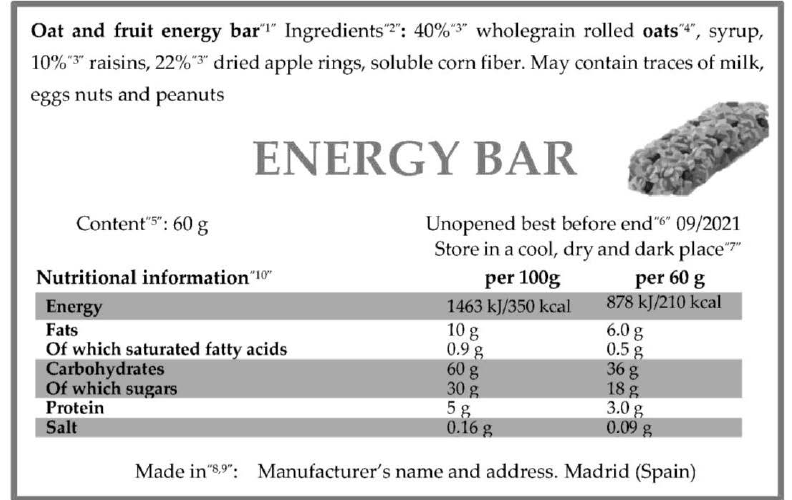
Figure 1. An example of a sport food label. Adapted from a commercial product. According to the European Regulation (Table 1), this sport food includes the following specific information. 1 The foodstuff designation (oat and fruit energy bar) that describes the product. 2 An ingredients list in descending order of weight, preceded by the word ingredients. 3 Quantity indication of certain ingredients or category of ingredients (oats, raisins, apple). The amounts of these ingredients must be indicated because they are mentioned in the name of the food (oat and fruit energy bar). 4 Substances causing allergies or intolerances (oats) clearly distinguished from the rest of the ingredients (in bold font in this case). 5 Net quantity (in grams). 6 Minimum durability date. 7 Storage conditions or